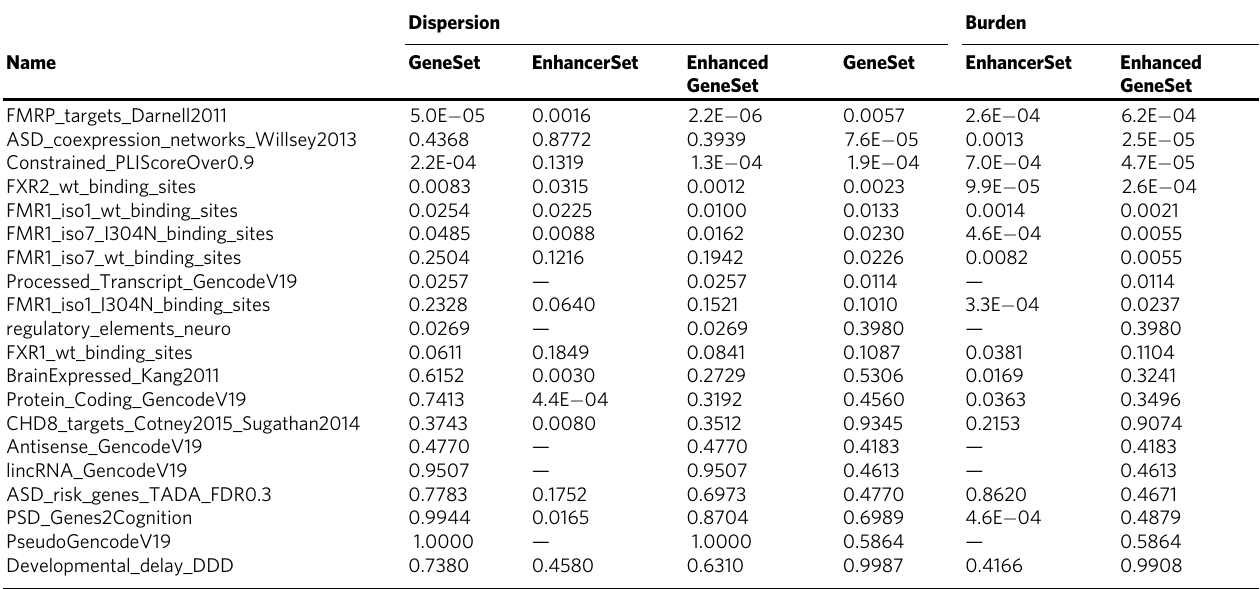
For each gene set, we consider three related sets: the original gene set, enhancers predicted to interact with genes in the set, and an enhanced gene set containing both genes and the predicted enhancers. p -values from enrichment analyses are reported; those smaller than Bonferroni threshold = 0.05/20 = 0.0025 are